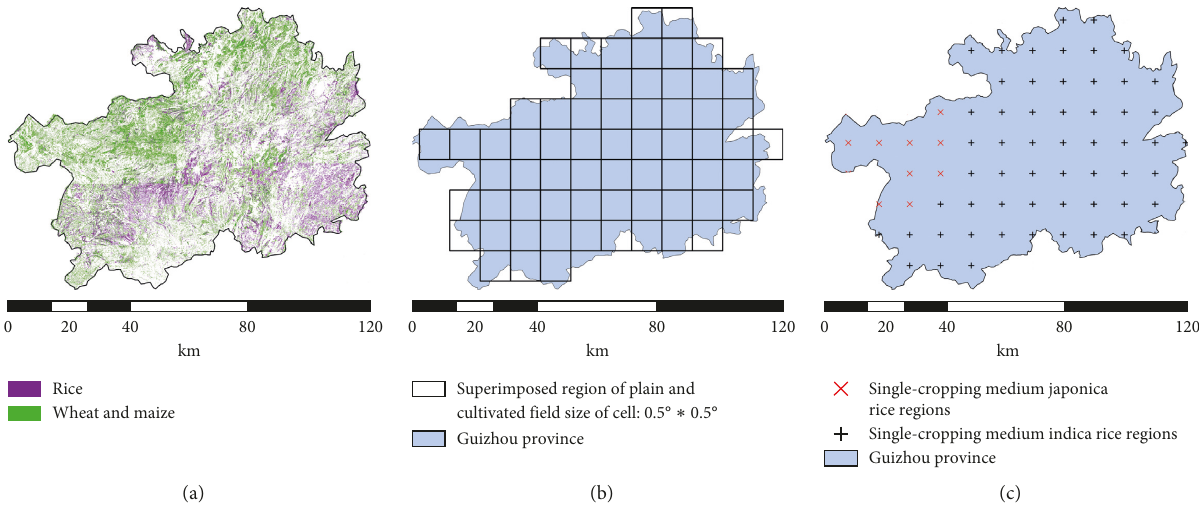
Figure 13: Cultivated field and grid map of superimposed area in